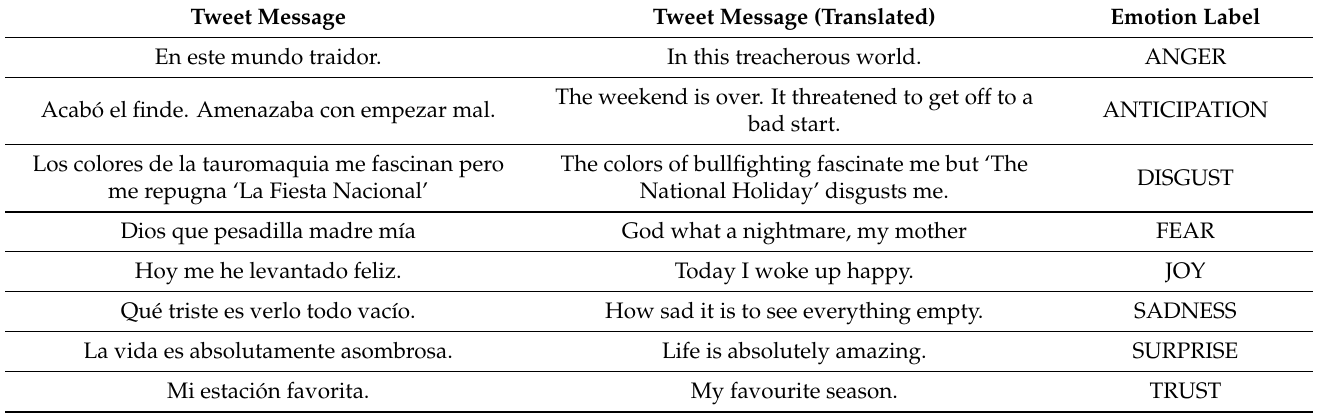
Table 7. Examples of tweets tagged by emotion.